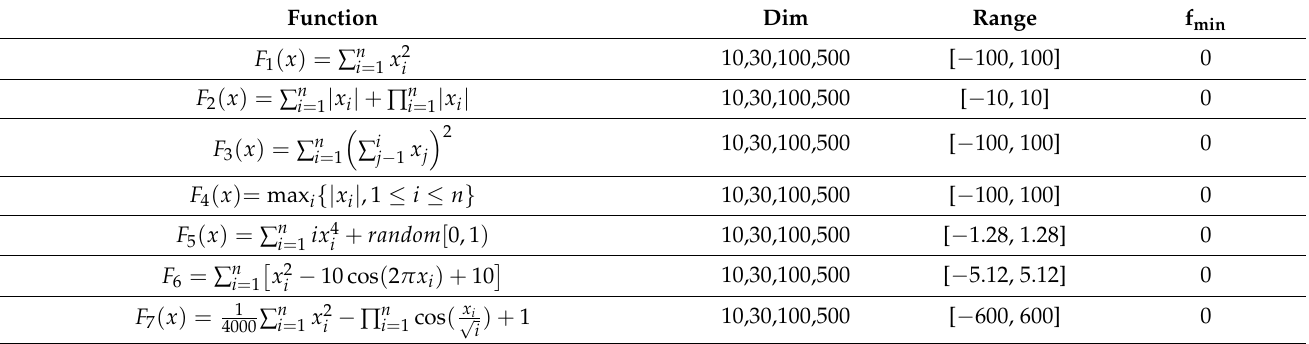
Table 3. Unimodal benchmark